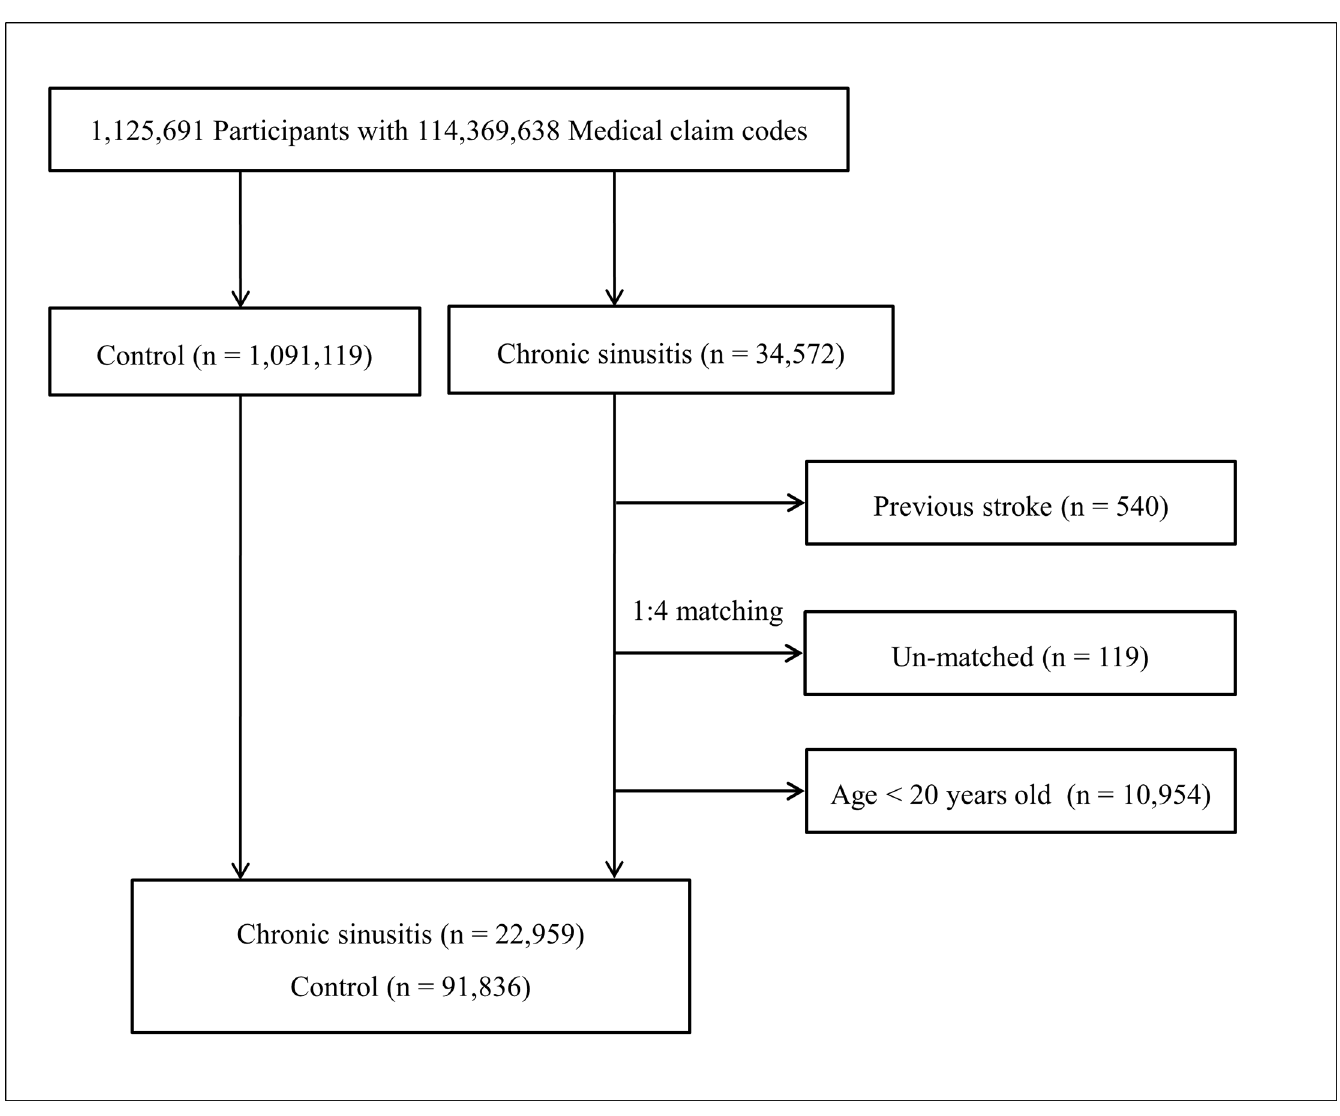
Fig 1. A schematic illustration of the participant selection process that was used in the present study. Of 1,125,691 cases with 114,369,638 medical claim codes, 34,572 CRS participants were selected. The participants of previous stroke history were excluded (n = 540). The CRS participants were matched 1:4 with a control group who had not been diagnosed with CRS. Un-matched CRS participants (n = 119) and less than 20 years old participants (n = 10,954) were excluded. Finally, 22,959 CRS participants and 91,836 control participants were